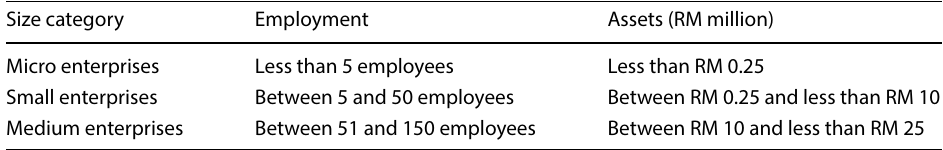
Table 1 Classification adopted by SME Crop on MSMEs in